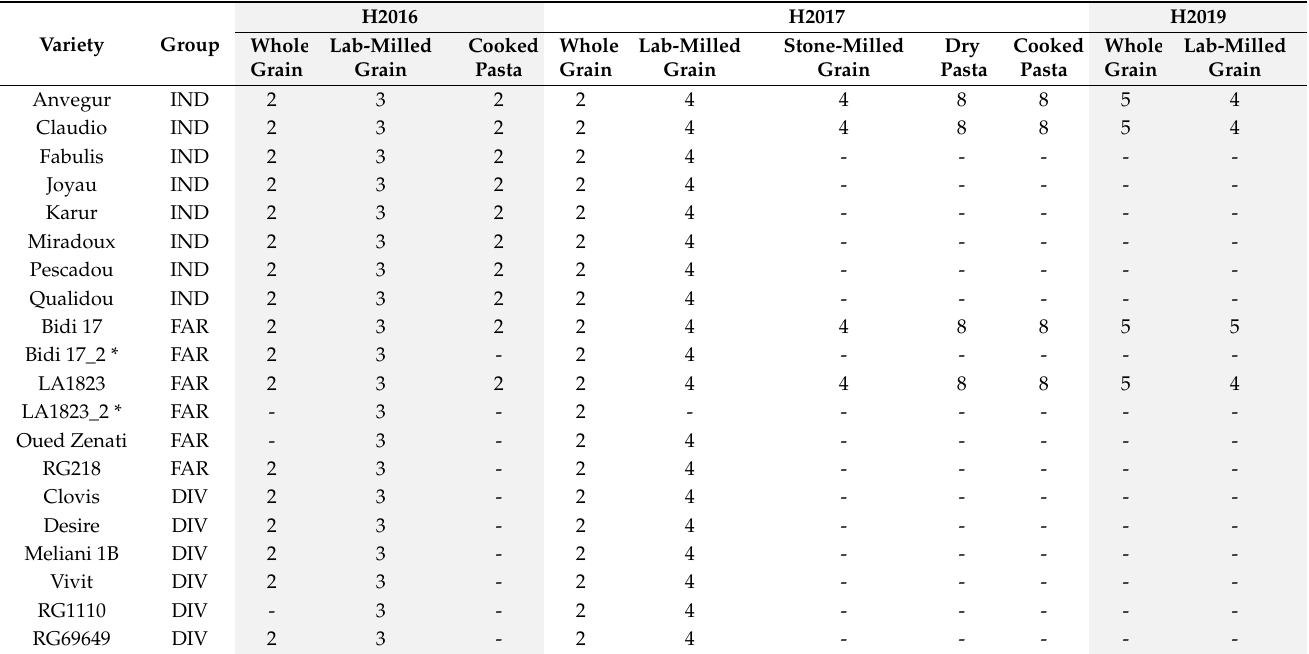
Table 1. Varieties of wheat and number of replicates analyzed by type of product (whole grain, lab-milled grain, stone-milled grain or lab-milled grain, dry and cooked pasta) by variety and over the 3 years of harvest (H2016, H2017,